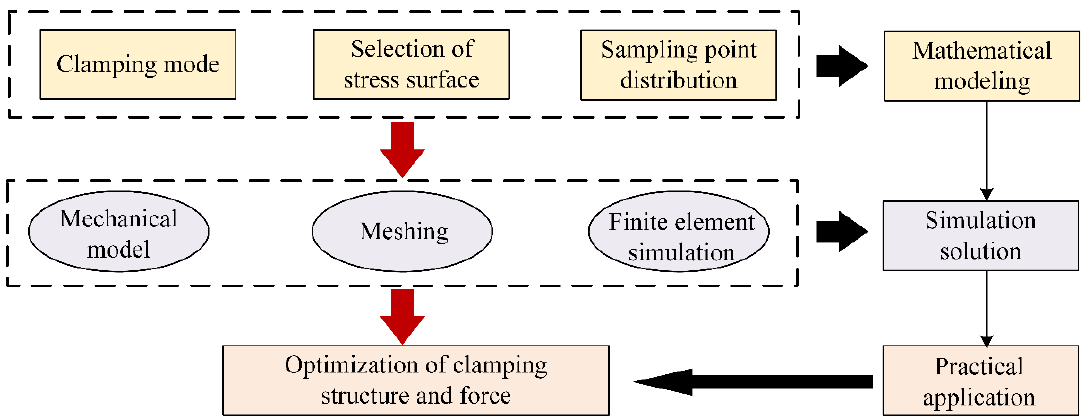
Figure 1. Overall scheme of clamping deformation analysis technology based on clamping force control.